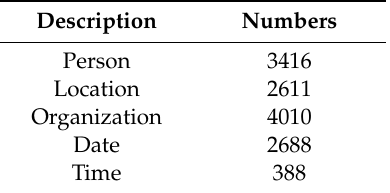
Table 4. Summary of the public NE-tagged